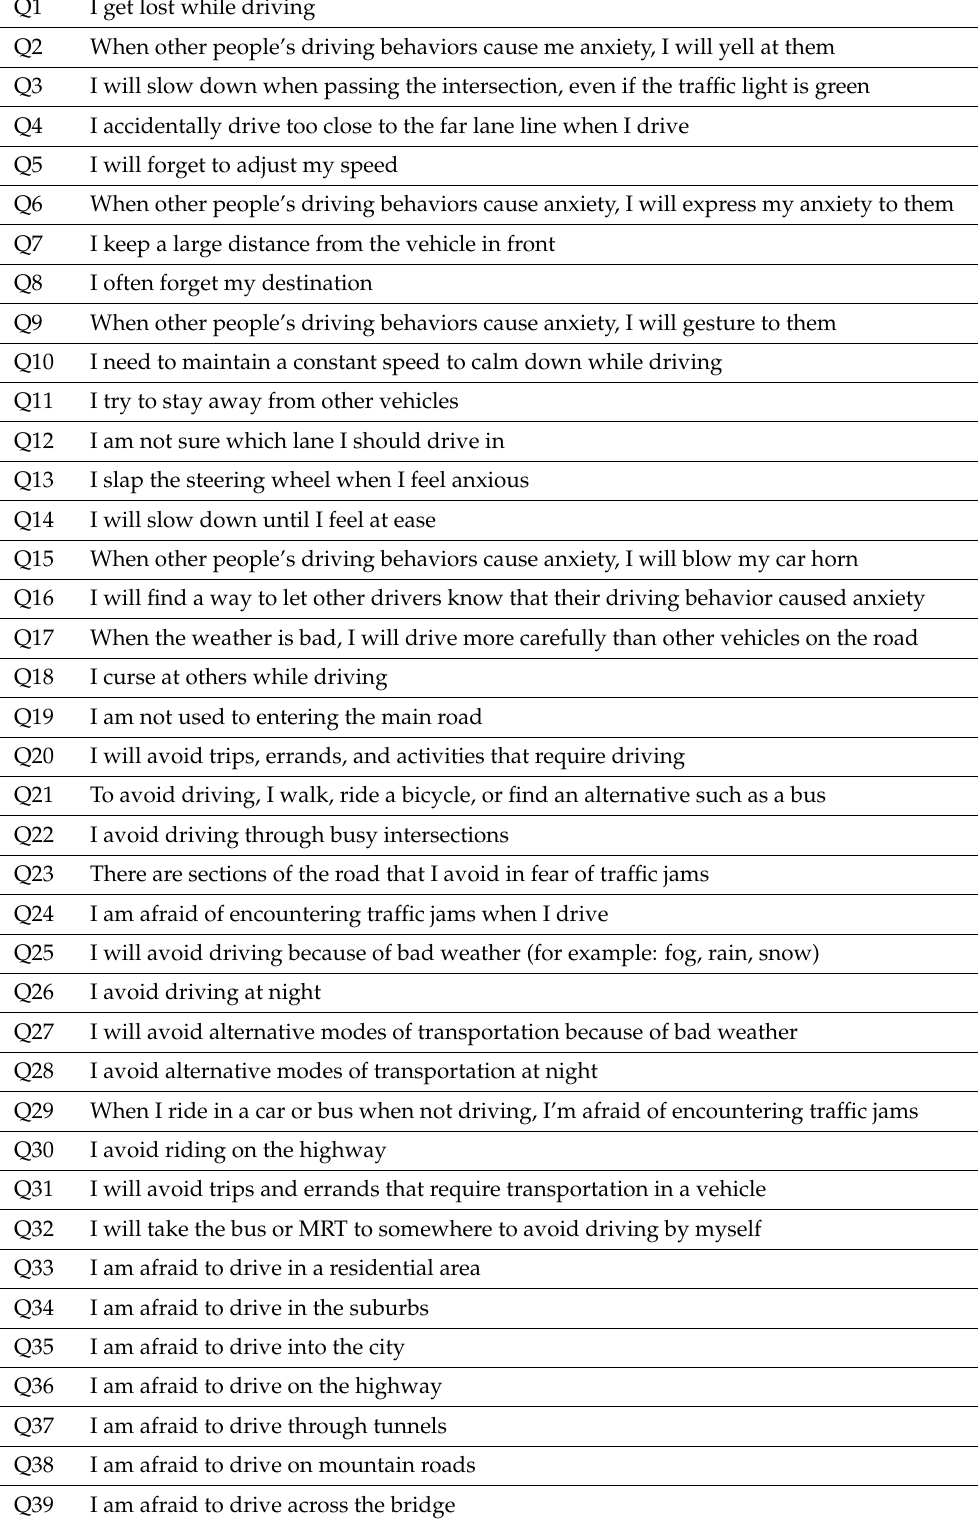
Table 1. Self-measurement driving behavior